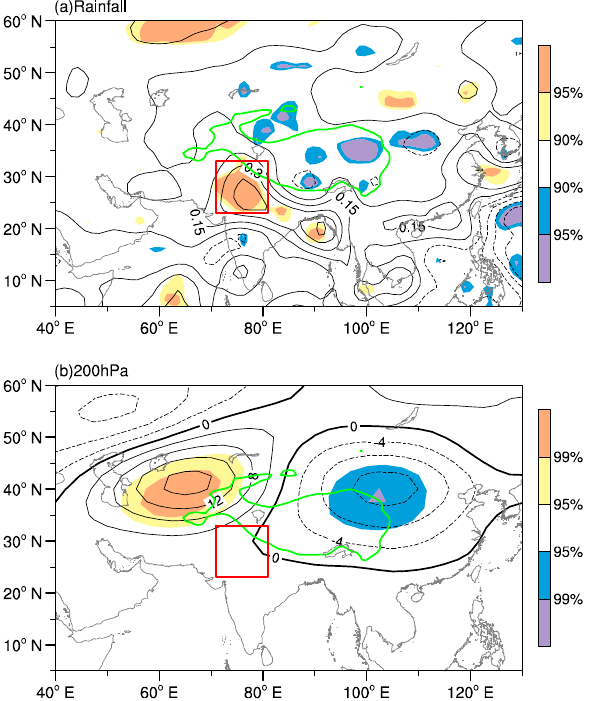
Figure 4. ( a ) Summer rainfall anomalies (units: mm) obtained by regression on the preceding April Indian SM index for the period 1981–2019. Contours are drawn every 0.15 mm. ( b ) As in ( a ) but for 200-hPa geopotential heights anomalies. Contours are drawn every 4 gpm. The solid and dash lines denote positive and negative values, respectively. The bold black line in ( b ) is zero. The red box (23° N–32° N, 70° E–80° E) indicates the location of anomalous rainfall. Shadings in ( a ) denote rainfall anomalies significant at the 90% and 95% confidence levels. Shadings in ( b ) denote geopotential height anomalies significant at the 95% and 99% confidence levels.